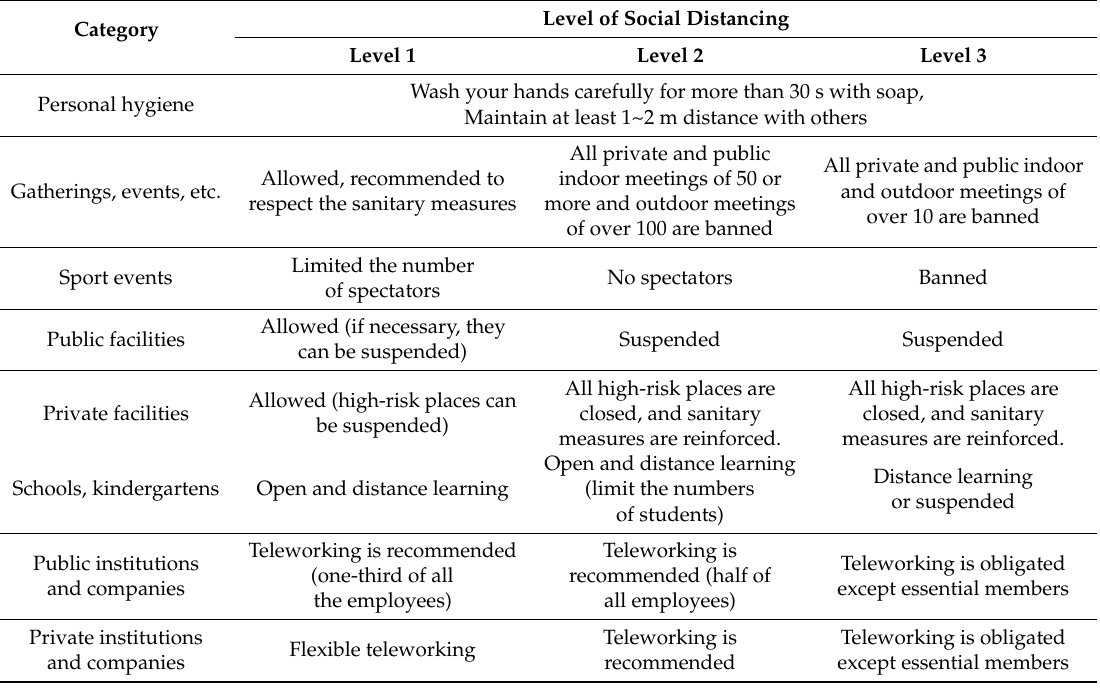
Figure 1. Location of Seoul and Daegu in Korea. Red dots present the location of air quality monitoring stations (AQMS). This map was produced by using ArcMap 10.6 of ArcGIS software. Table 1. Guidelines on social distancing issued by the Government of South